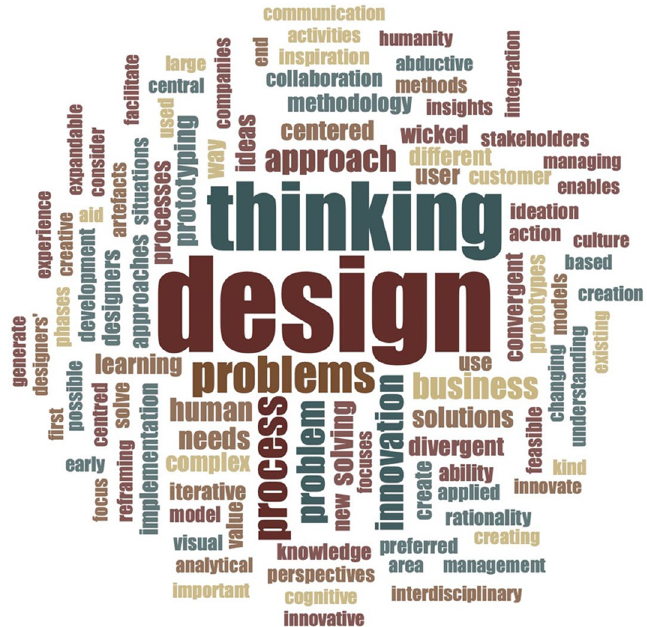
Fig. 2 Word cloud created based on word